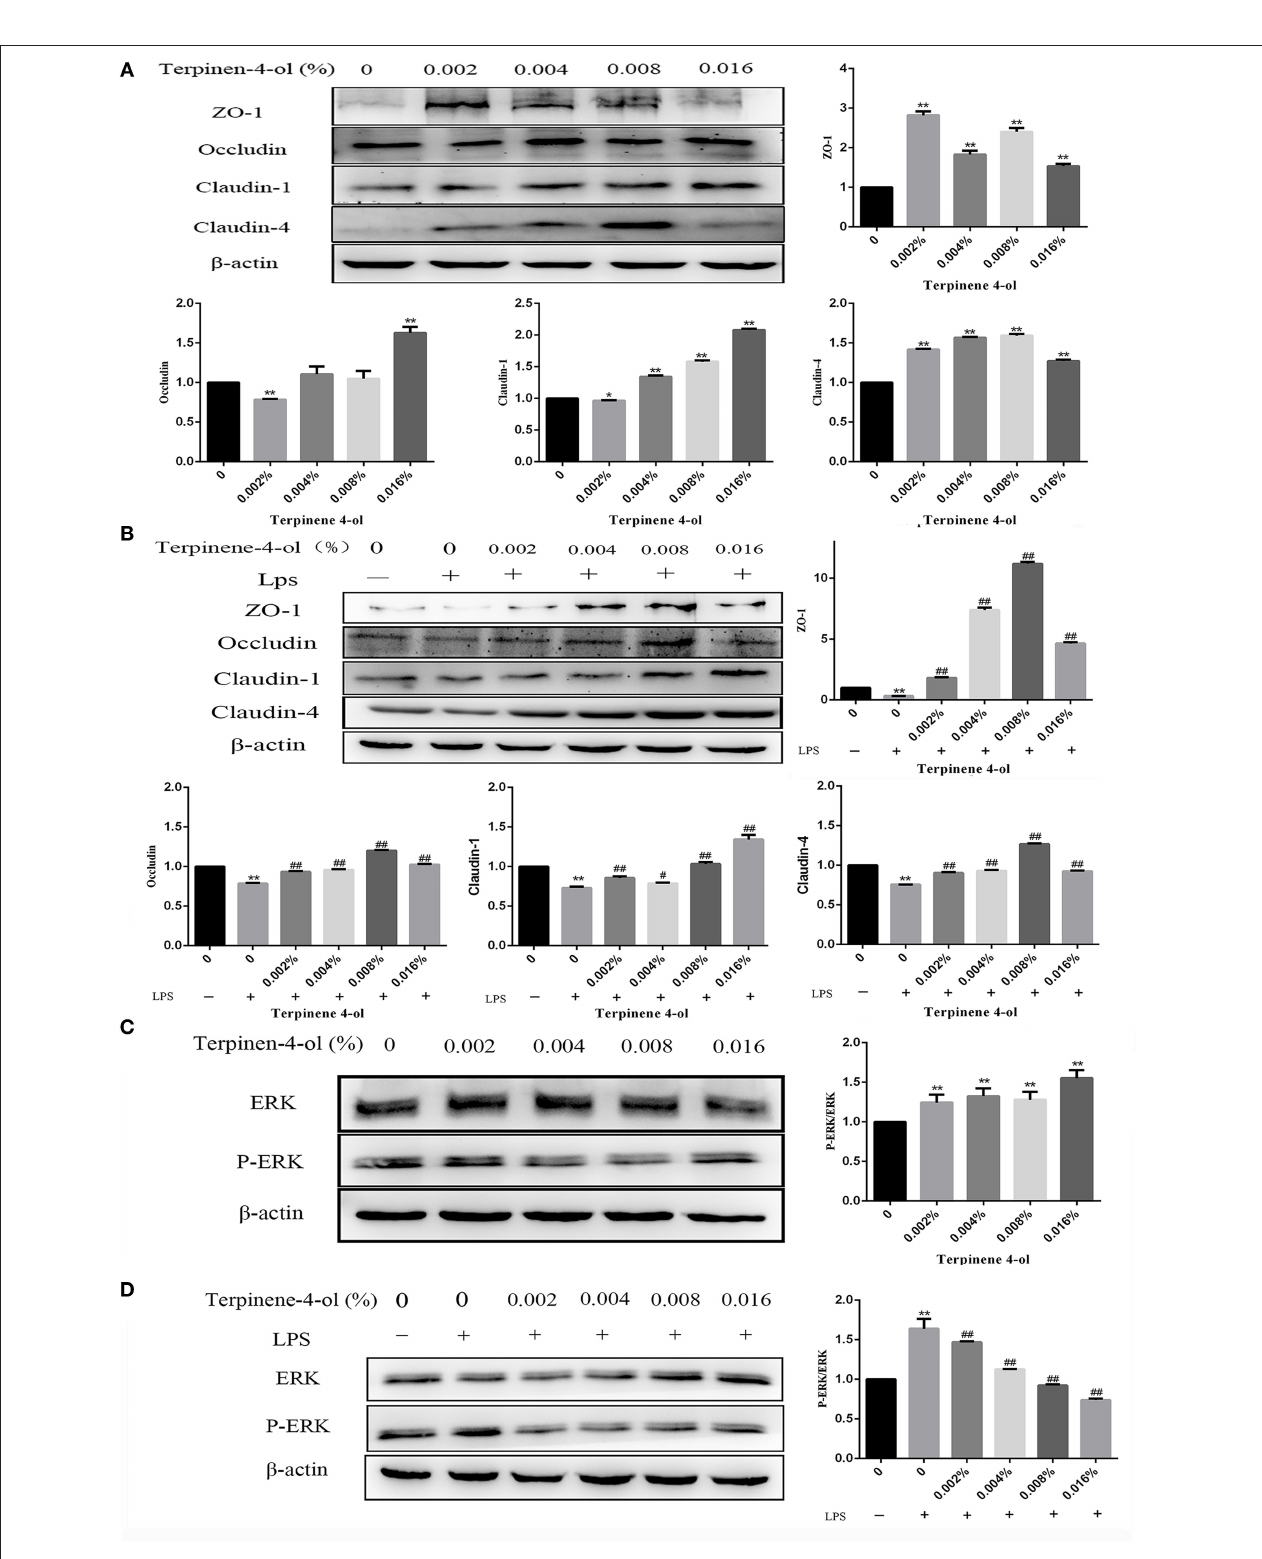
FIGURE 5 | Effect of TER on tight junction (TJ) proteins and phosphorylated ERK expression in IPEC-J2 cells. (A) The TJ proteins expression were detected in cells exposed to a serial concentration of TER. (B) The TJ proteins’ expression in cells incubated with TER for 24h and then exposed to LPS. (C) ERK and phosphorylated ERK expression in cells incubated with TER for 24h. (D) ERK and phosphorylated ERK expression in cells incubated with TER for 24h and then exposed to LPS. ** and ## display similar means with above mentioned.